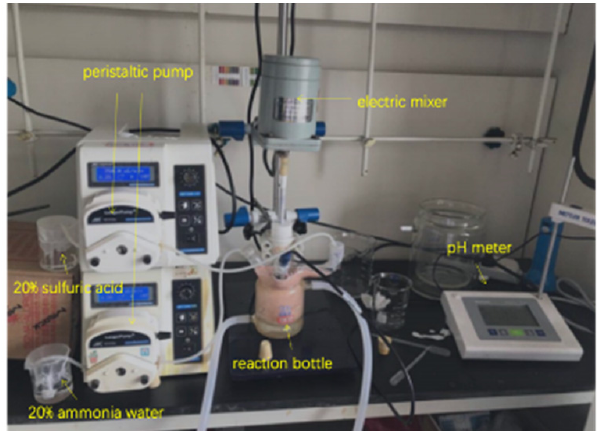
Figure 3. Experimental set-up for enzymatic hydrolysis.